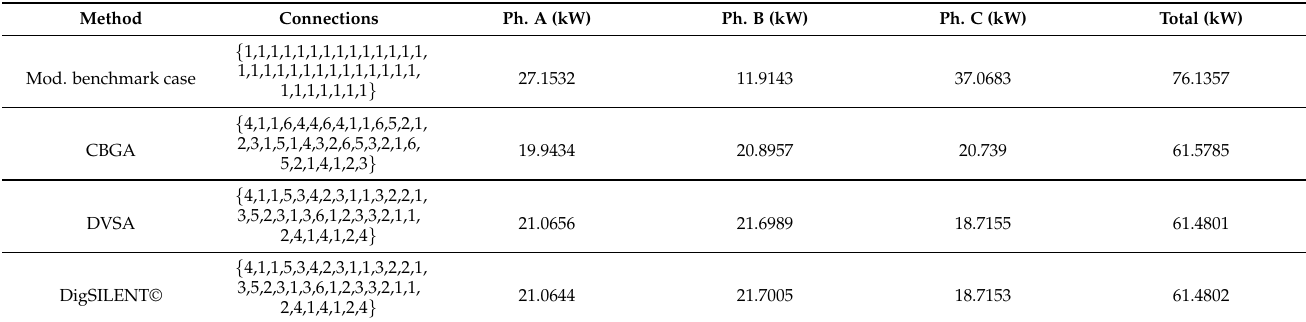
Table 13. Results of the optimal phase-balancing in the 37-node test